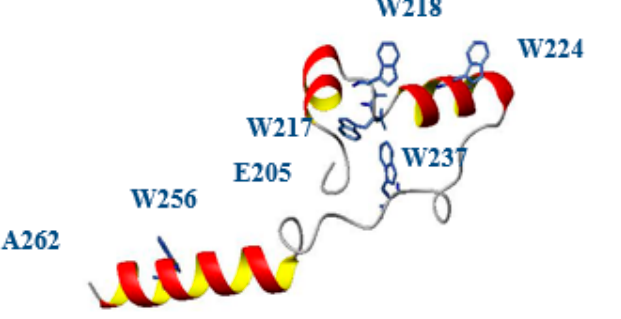
Figure 3. Homology model of L0 loop. The loop includes the region between residues E205 and A262. The PDB structure 5UJ9 corresponding to MRP1 was used as template.